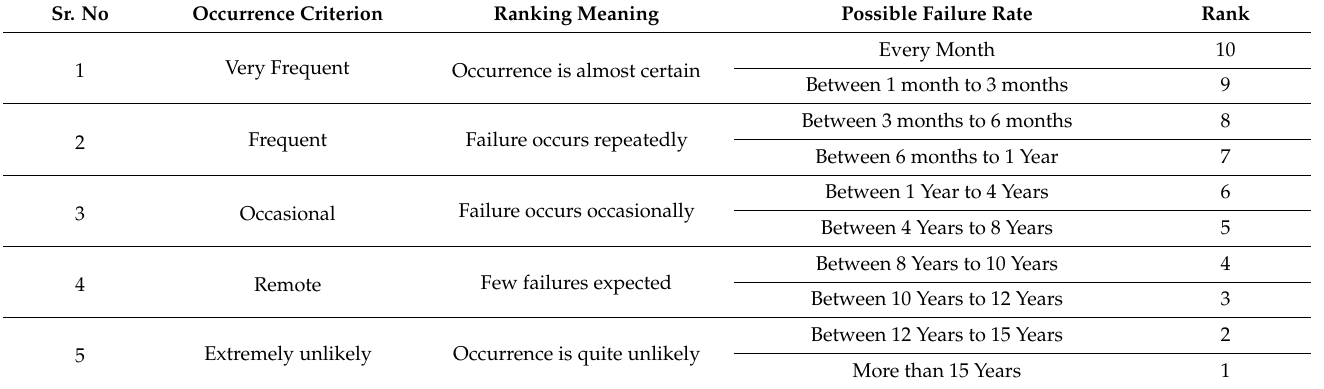
Table 2. FMECA scale to rate occurrence (O).